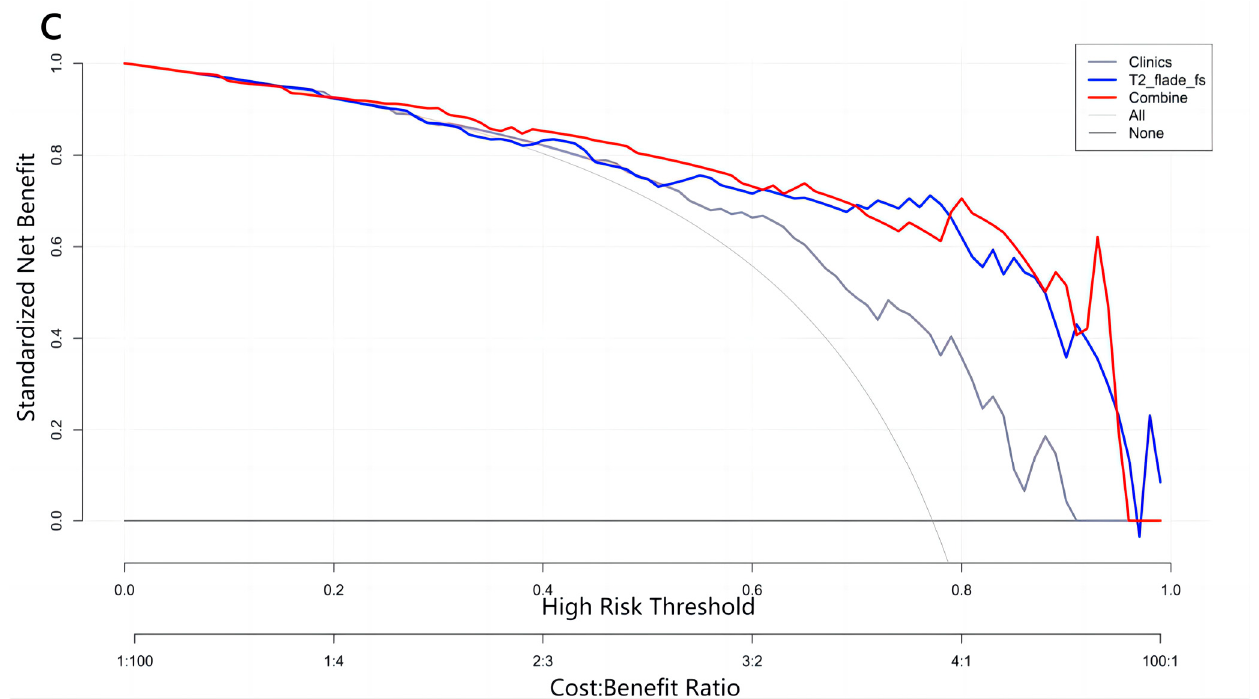
Figure 5. Calibration curve and decision curve analysis. The calibration curves of the training group ( a ) and the validation group ( b ) prove that the Rad scores of the T2 model, the clinical model, and the joint model have good fitness. ( c ) Decision curve analysis of the T2 model, the clinical model, and the joint model. The Y-axis represents the net benefit, which is calculated by adding up the benefits (gaining true positives) and subtracting the weighted harms (deleting false positives). A model is considered the best method for feature selection if it has the highest net benefit. Note—T2 flade fs = T2 fblade fs/T2 ssfse tra bh.